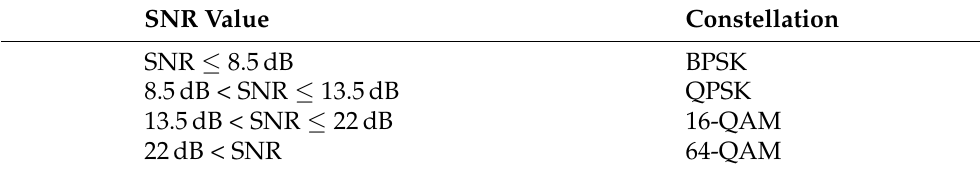
Table 1. Relationship between the SNR and the modulation scheme that a digital system can use to transmit without errors over an AWGN channel. The data were obtained from